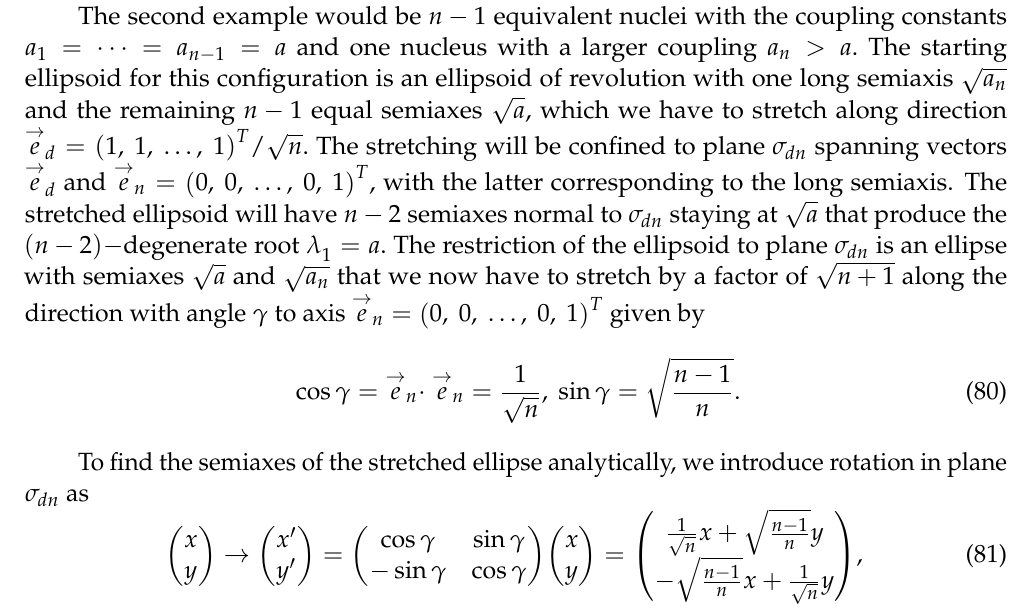
Figure 3. The transform for several representative cases of a three ‐ nuclei system: stretching a 3D ellipsoid a factor of 2 along the spatial diagonal 1,1,1 / 3. T Legends in the panels indicate semiaxes of the starting ellipsoid in r.u. that are equal to square roots of the original hyperfine coupling constants a i , while squared semiaxes q i of the stretched ellipsoids give the sought energies 3 ∑ + 1 q 2 a k , i = 0, . . . , 3, q 0 = as E i = − 1 i 2 4 k = 1